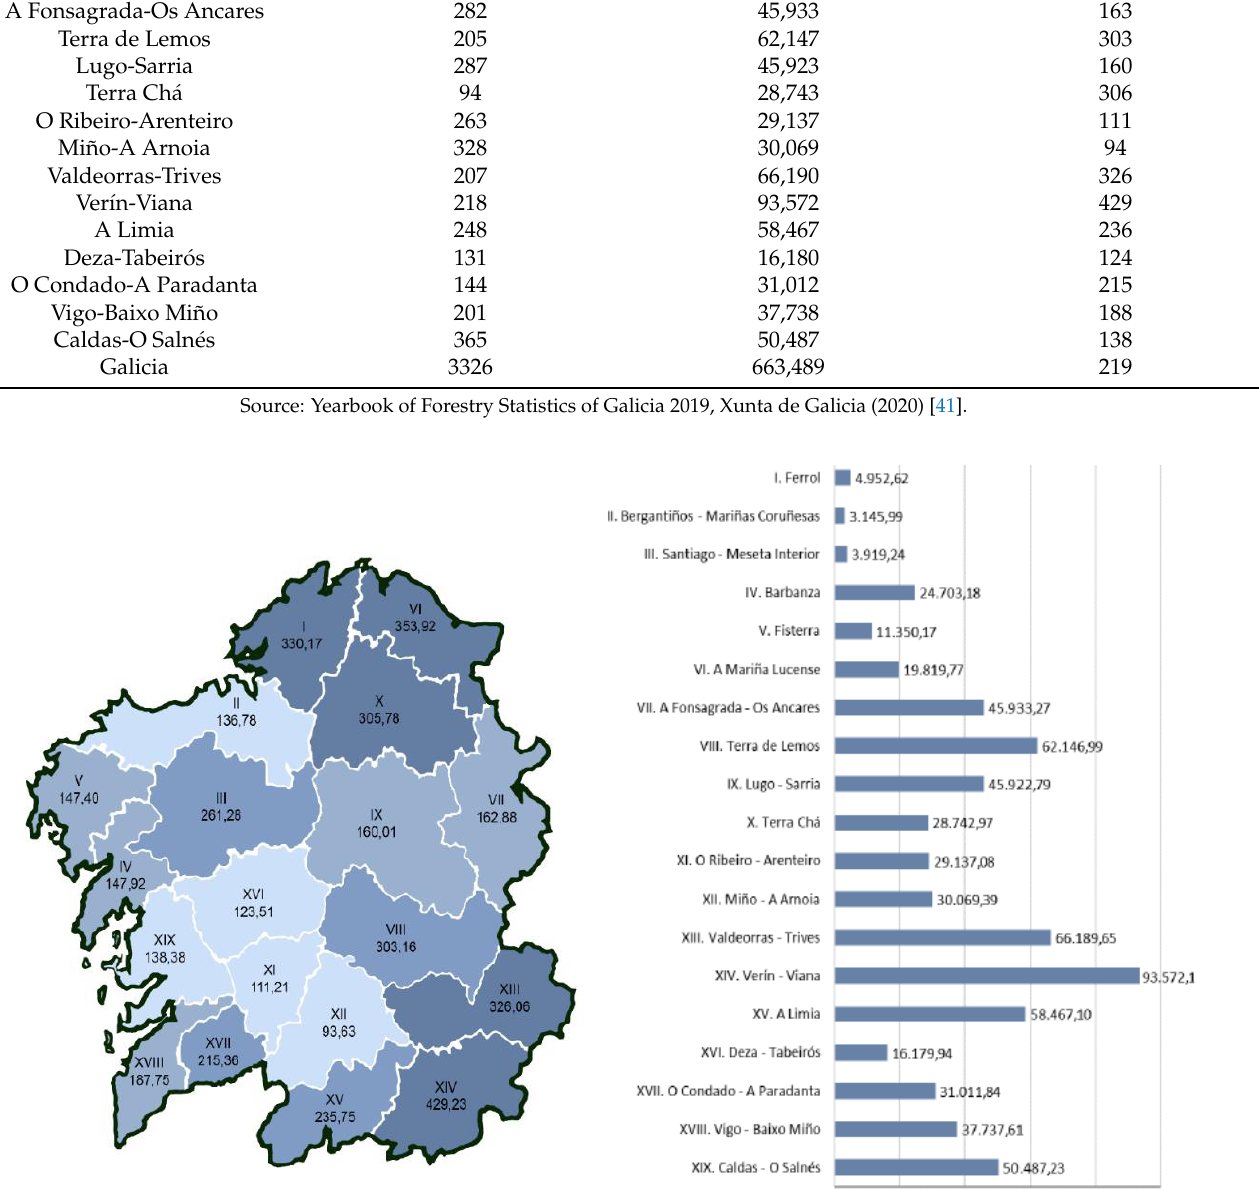
Figure 2. Location of communal forests and average area per district in Galicia (in hectares). Source: Yearbook of Forestry Statistics of Galicia 2019, Xunta de Galicia (2020) [41].